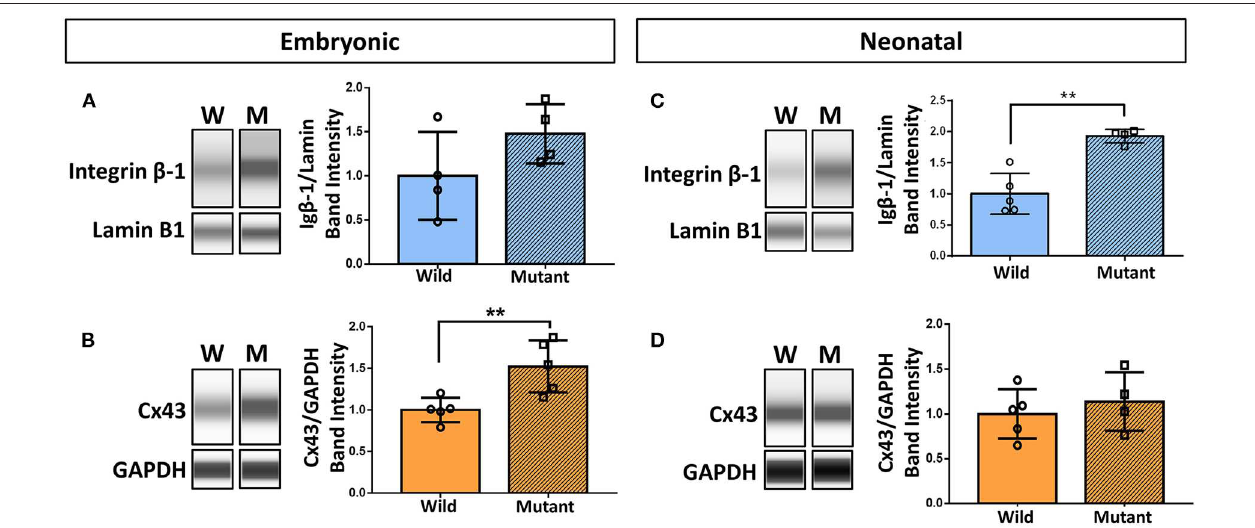
FIGURE 5 | Western blotting demonstrates increased integrin β -1 and connexin 43 expression in neonatal and embryonic mutant Nkx2-5 hearts, respectively. Capillary-based Western botting images and corresponding quantifications of embryonic wild type and mutant (A) integrin β -1 and (B) connexin 43 (Cx43), and neonatal wild type and mutant (C) integrin β -1 and (D) connexin 43. Graphs display mean ± standard deviation of protein band intensities normalized to either lamin B1 or GAPDH housekeeping proteins. Significance ** p < 0.01. n = 8 total for embryonic and 9 total for neonatal integrin β -1 Westerns. n = 10 total for embryonic and 9 total for neonatal connexin 43